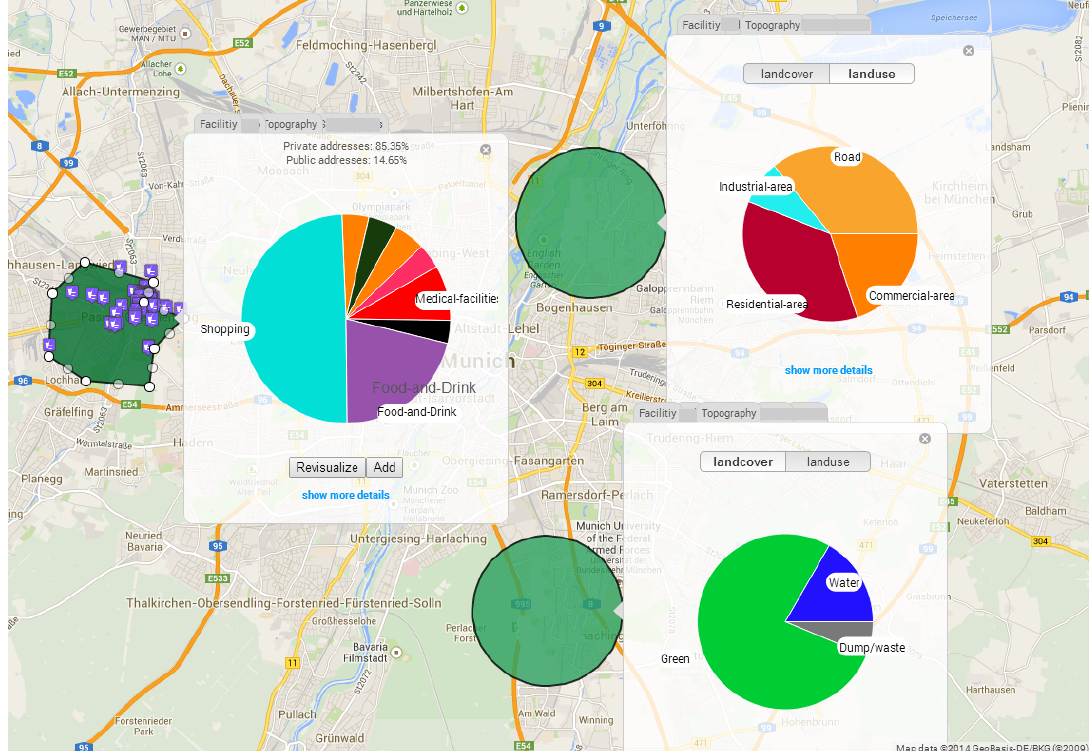
Figure 4 . Spatial overview of user-selected